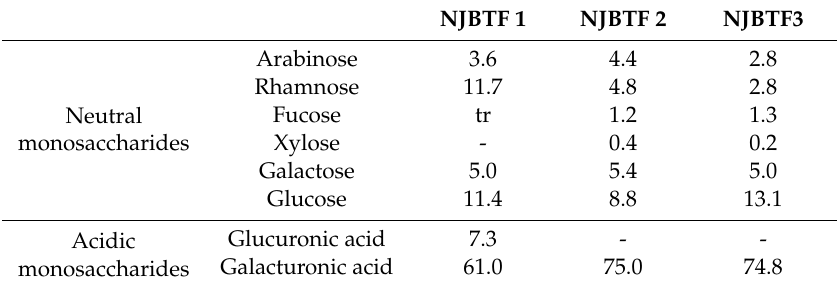
Table 4. Percentage of a SINGLE sugar related to the total amount of sugar obtained through gas chromatography. Tr = trace amount.